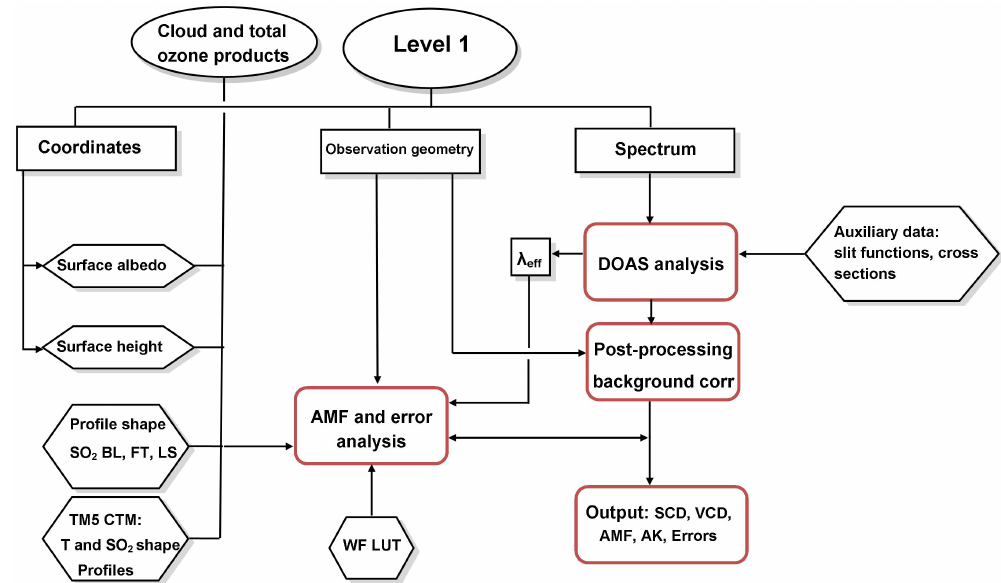
Figure 2. Flow Diagram of the TROPOMI DOAS retrieval algorithm for SO 2